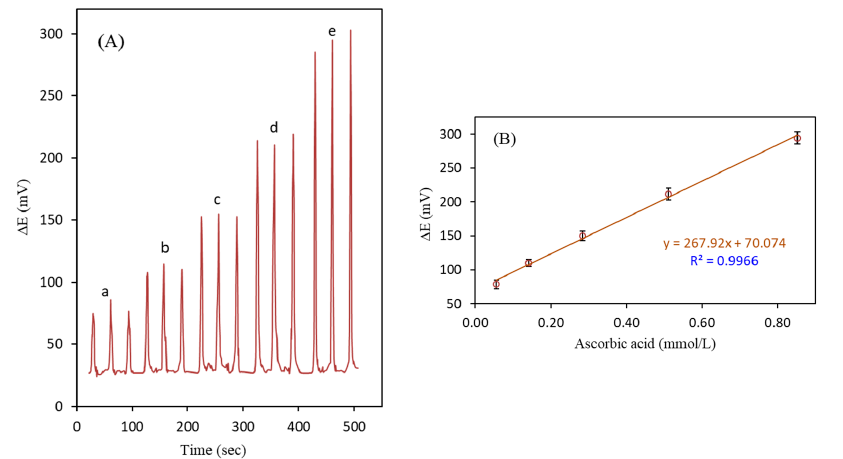
Figure 8. SIA-DEP potential peak intensity in triplicate of (a) 60.0, (b) 140.0, (c) 280.0, (d) 510.0, and (e) 850.0 µM of ascorbic acid at a DC current of 21 µA/cm 2 ( A ) and calibration curve ( B ). Figure 9. SIA-DEP potential peak intensity in triplicate of (a) 60.0, (b) 140.0, (c) 280.0, (d) 510.0, and (e) 850.0 µM of ascorbic acid at 20% bias of the Square wave ( A ) and calibration curve ( B ). Table 1. Analytical parameters for SIA-DEP determination of ascorbic acid at CNTs-Ag electrodes with comparison against reference standard iodimetric method. The number of measurements is 3.